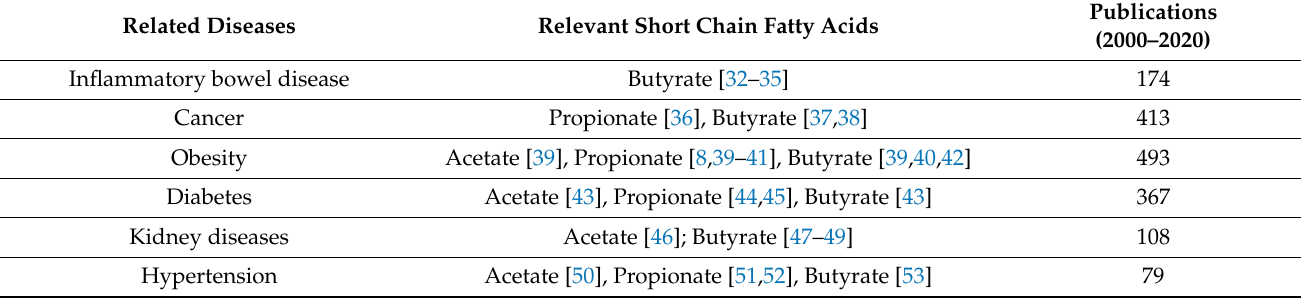
Table 3. Examples of SCFAs involved in the diverse diseases in vivo and in vitro studies for recent 20 years